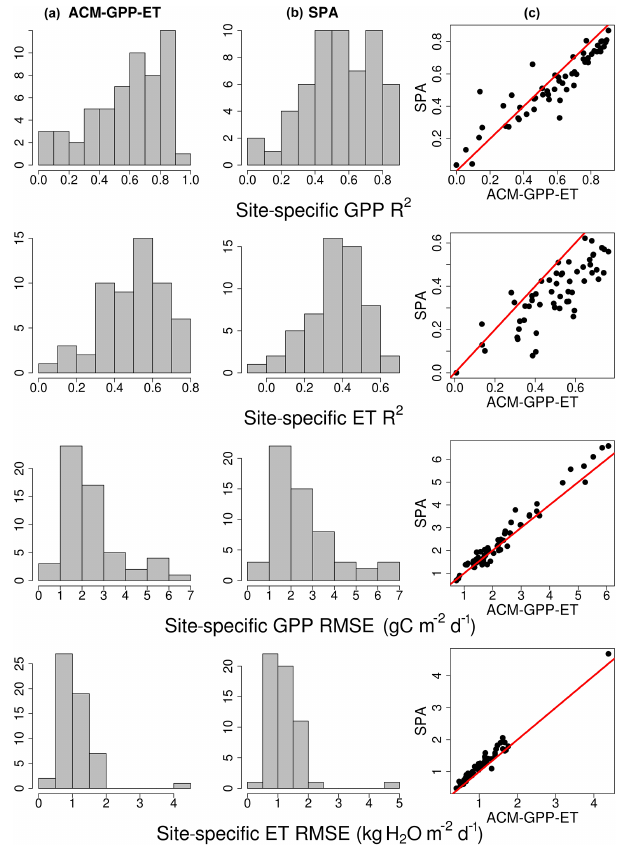
Figure 5. Comparison of ACM-GPP-ET and SPA simulating fully independent gross primary productivity (GPP) and evapotranspi- ration (ET) from FLUXNET2015. The histograms show the site- specific R 2 and RMSE. SPA is shown in (a) , and ACM-GPP-ET is in (b) . The panels in (c) show the site-by-site comparison of statis- tical metrics achieved by each